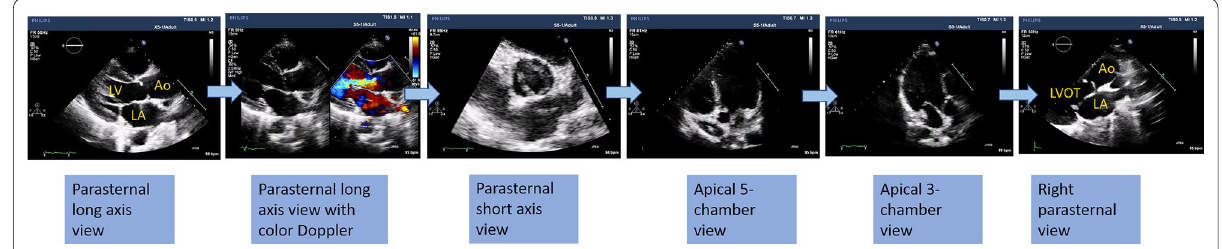
Fig. 1 2D TTE imaging sequence for the aortic–subaortic complex